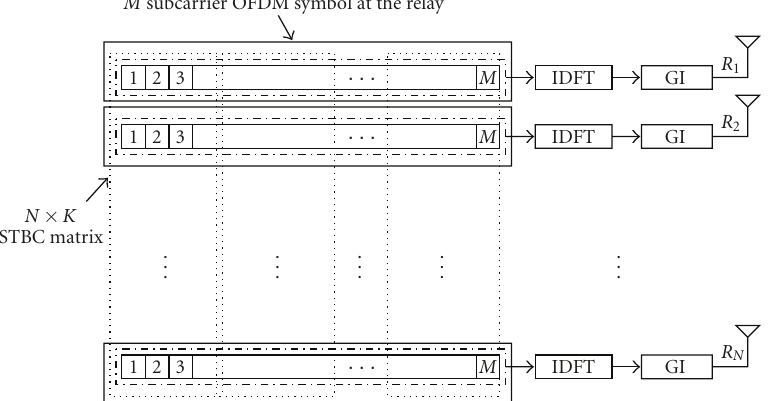
Figure 3: Space-frequency block coding at the